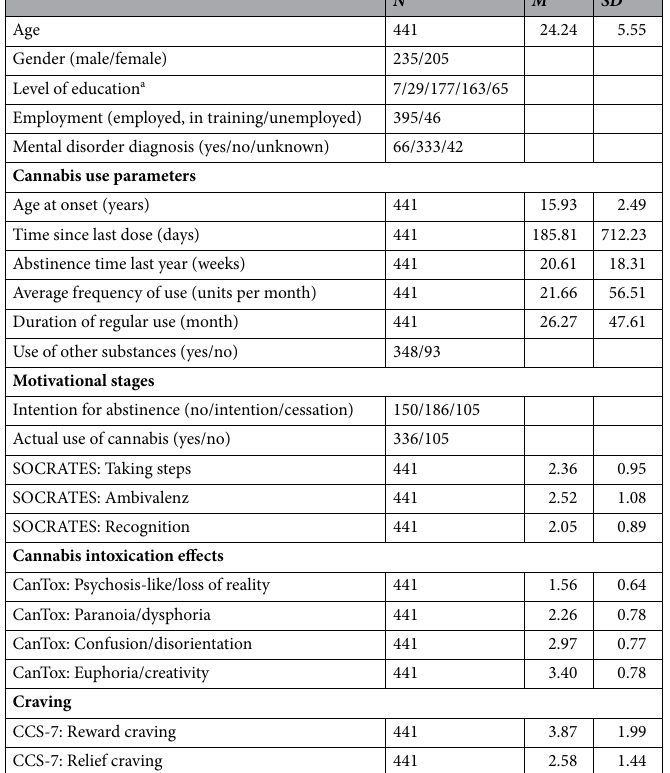
Table 1. Descriptive date of the sample. a Elementary school degree after grade 9/intermediate school degreee after grade 10/A-level grade 13/University degrees/Apprenticeship; CanTox, Cannabis-intoxication questionnaire; CCS-7, Cannabis Craving Screening with 7 items; SOCRATES, Questionnaire assessing motivational stages; N , frequency, M , mean value, SD , standard